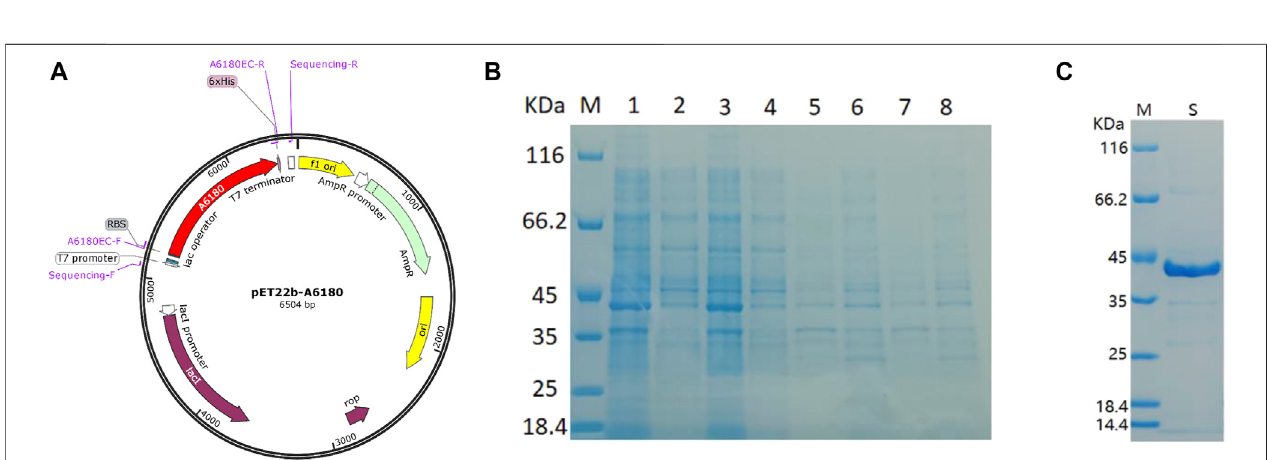
FIGURE3| HeterologousexpressionofA6180in E.coli . (A) Schematicdiagramoftheconstructionofrecombinantoverexpressionvector. (B) SDS-PAGEanalysis of the protein expression ofpositivetransformants under the four inductive expression conditions. M: protein marker; 1: 37 ° C1.0 mmol/L IPTG induced precipitation; 2: 37 ° C1.0 mmol/L IPTG inducedsupernatant sample; 3: 37 ° C 0.2 mmol/L IPTG induced precipitation sample;4: 37 ° C0.2 mmol/L IPTG induced supernatantsample; 5: 15 ° C 1.0 mmol/L IPTG induced precipitation sample; 6: 15 ° C 1.0 supernatant sample after induction of mmol/L IPTG; 7: precipitation sample after induction of 0.2 mmol/L IPTG at 15 ° C; 8: sample of supernatant after induction of 0.2 mmol/L IPTG at 15 ° C. (C) Puri fi ed recombinant protein expressed in E. coli . M: marker; S: Puri fi ed